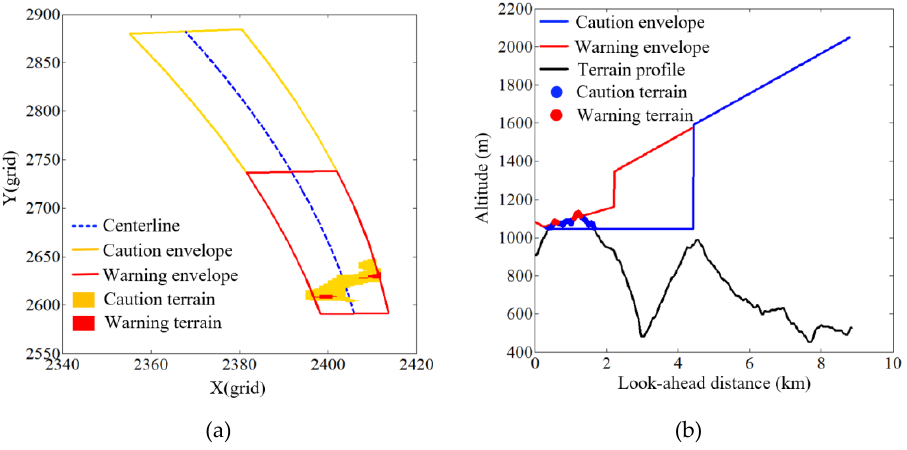
Figure 7. RFLTA example for rectilinear flight: ( a ) horizontal view; ( b ) vertical view.